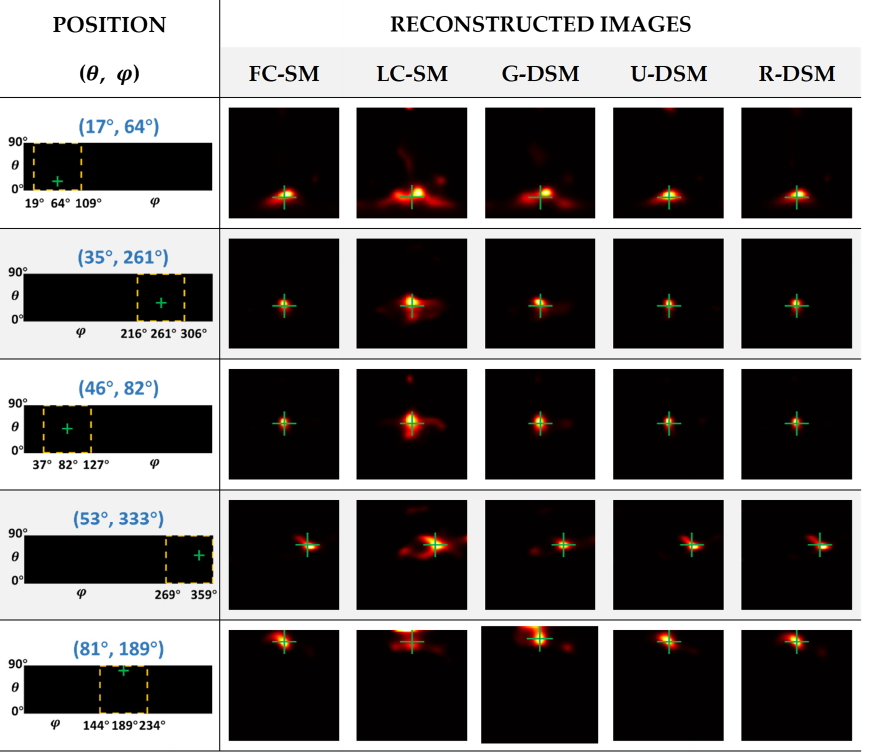
Figure 12. Reconstructed images of different SMs at representative positions for 99m Tc source in intra-device evaluation.